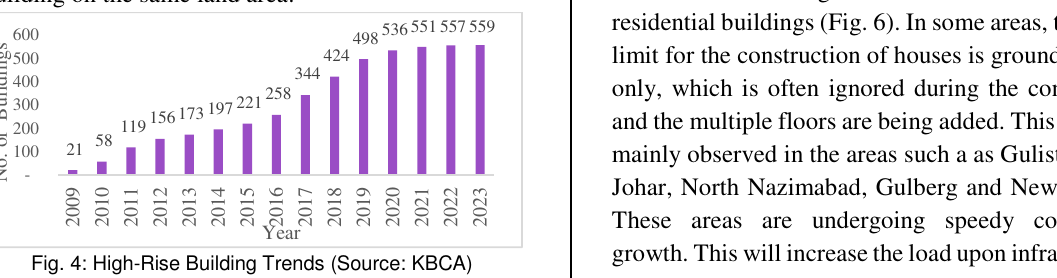
Fig. 4: High-Rise Building Trends (Source: KBCA)